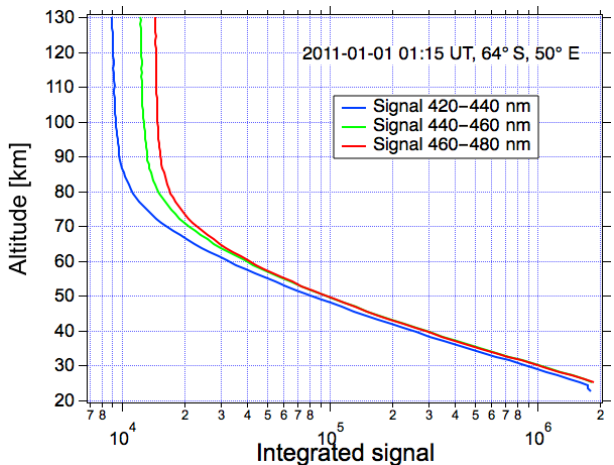
Figure 1. Spectrometer signal integrated in the three 20nm spectral ranges for one occultation on 1 January 2011 (star ID = 3, orbit number = 46209), lower background